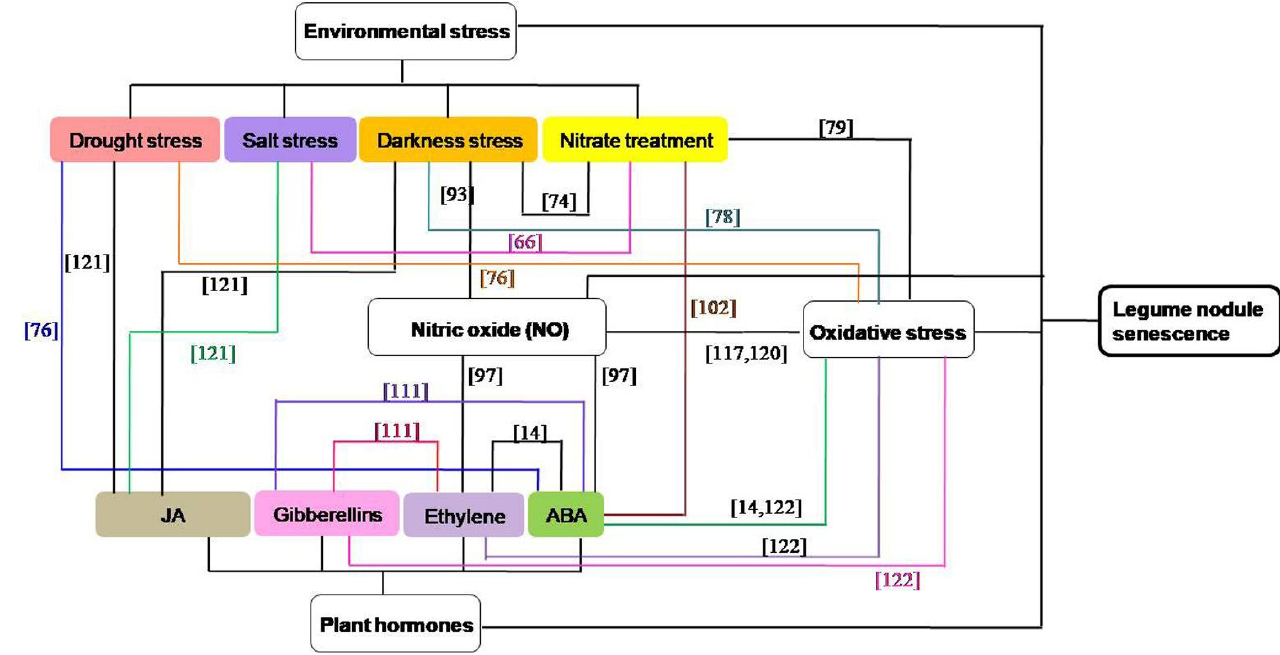
Figure 2. The interaction network of different abiotic factors in the regulation of the senescence of nodules [14,66,76,78,79,